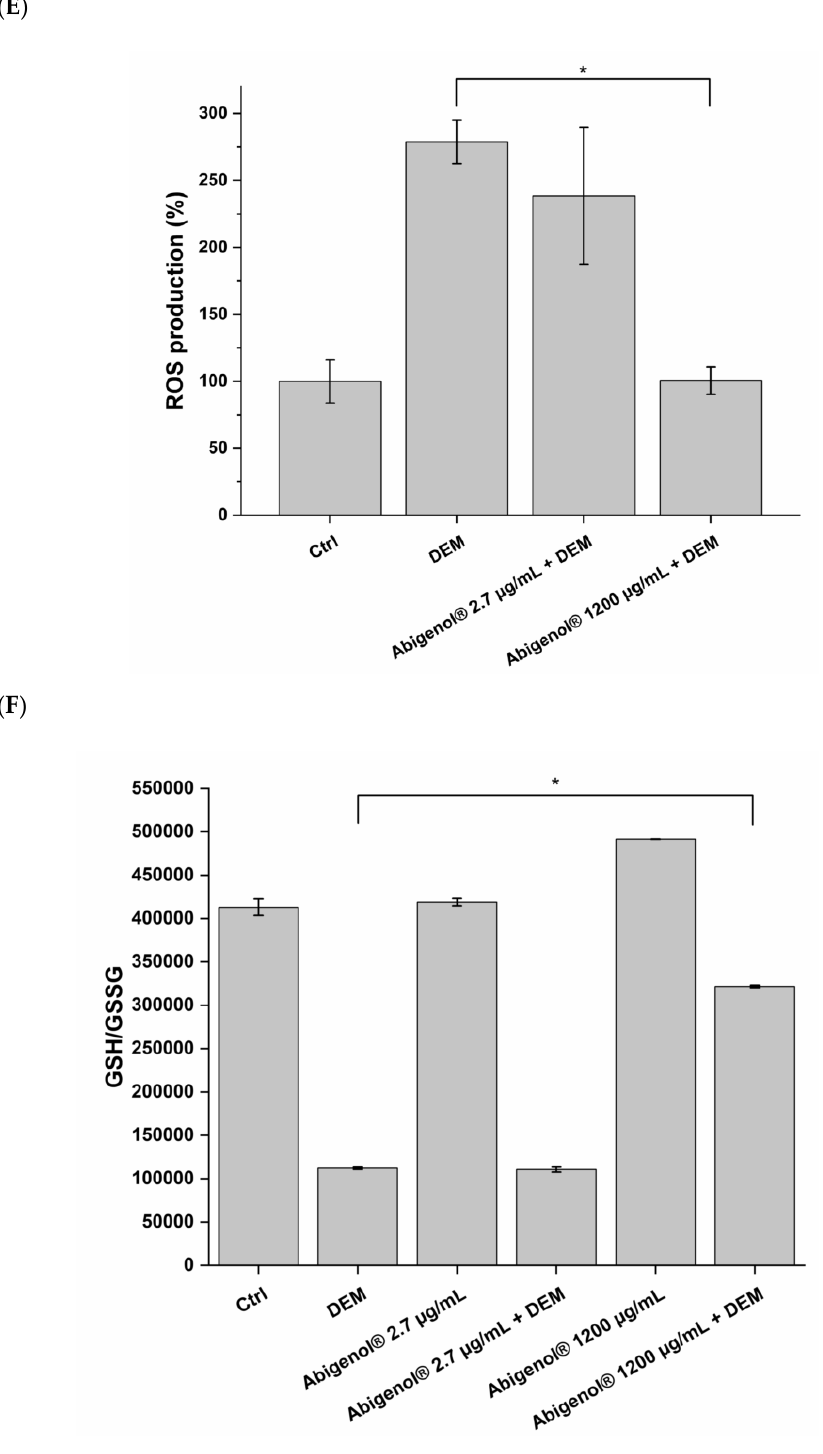
Figure 7. Impact of Abigenol ® on the cellular oxidative state, assessed as production of ROS, glutathione oxidation (GSH/GSSG ratio) or SOD activity of HUVEC ( A , B ), H9c2 ( C , D ) and HepG2 ( E , F ). Cells were incubated for 24 h in the presence of the formulation, followed by 2 h with the formulation + DEM. ROS were normalized on DAPI and expressed as fold-change of the untreated control; glutathione was normalized on total proteins in samples. Ctrl: control (untreated cells); DEM: diethylmaleate; AU: arbitrary units. * p < 0.05. (n = 3).